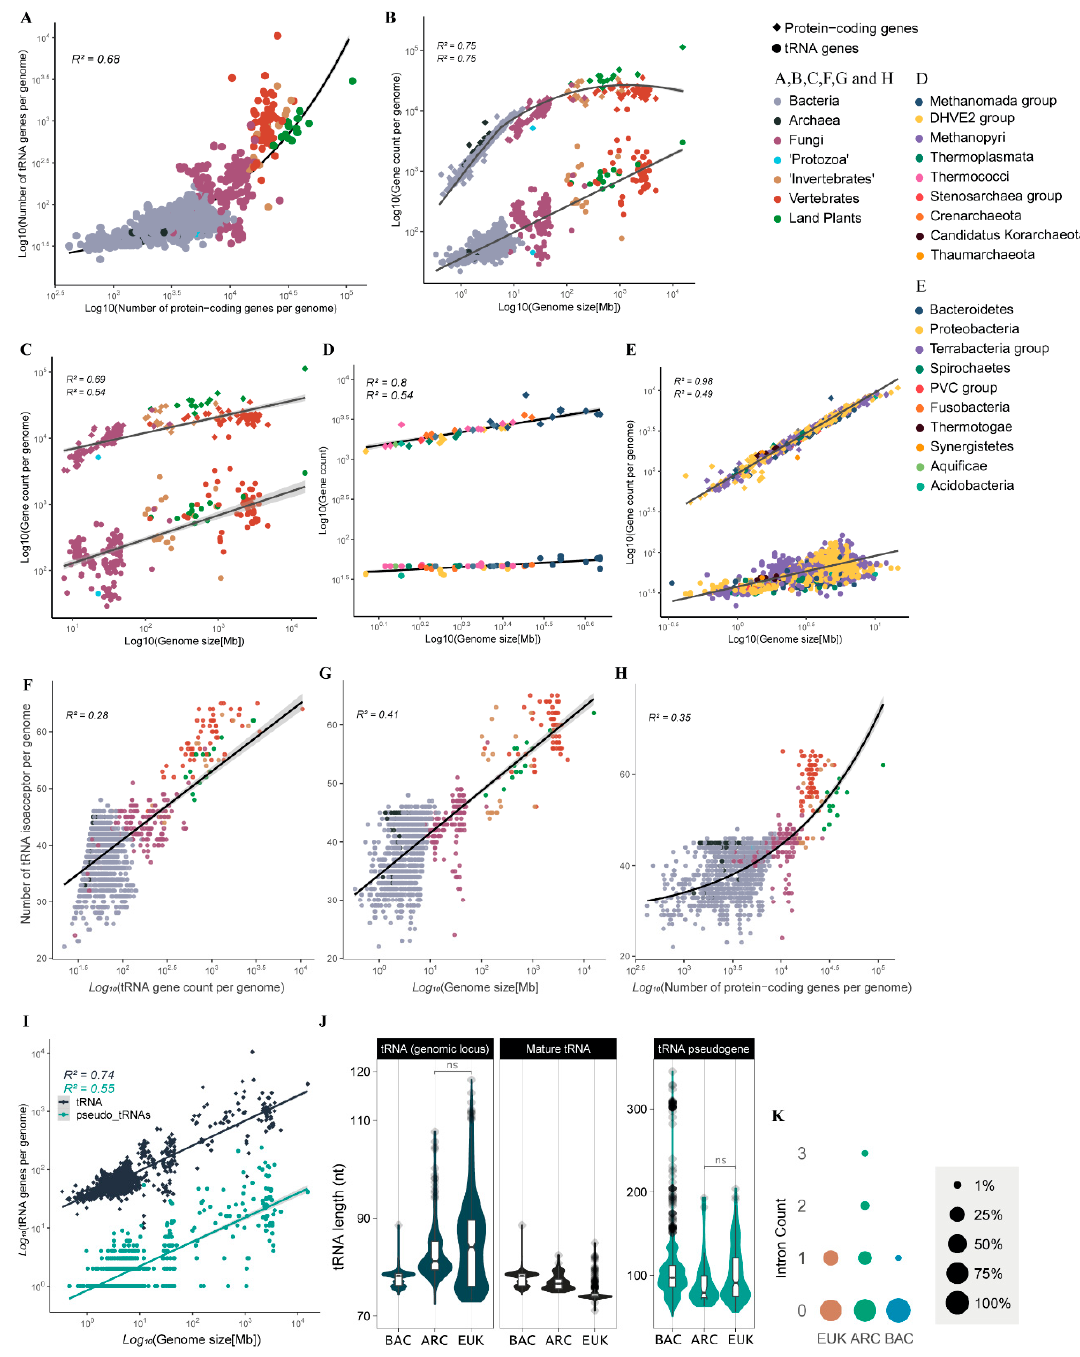
Figure 3. Macroevolutionary patterns of tRNA copy number and diversity across cellular organ- isms. ( A ) Correlation between the number of tRNA genes and protein-coding genes per genome. ( B ) Correlations between genome size and the number of tRNA genes and protein-coding genes per genome. The same as ( B ) for ( C ) eukarya, ( D ) archaea and ( E ) bacteria. Correlation between count of tRNA isoacceptors and number of tRNA genes per genome ( F ), genome size ( G ), and number of protein-coding genes per genome ( H ). ( I ) Correlation between the number of tRNA pseudogenes (along with tRNA functional genes) and genome size. ( J ) Distribution of length (nt) of tRNA genomic loci , mature tRNA and tRNA pseudogenes per domain, showing statistically significant differences, except for the non-significative contrasts between archaea and eukarya (ns, p -value > 0.05; see methods for statistical details). ( K ) Frequency of tRNA genes containing a given number of introns per